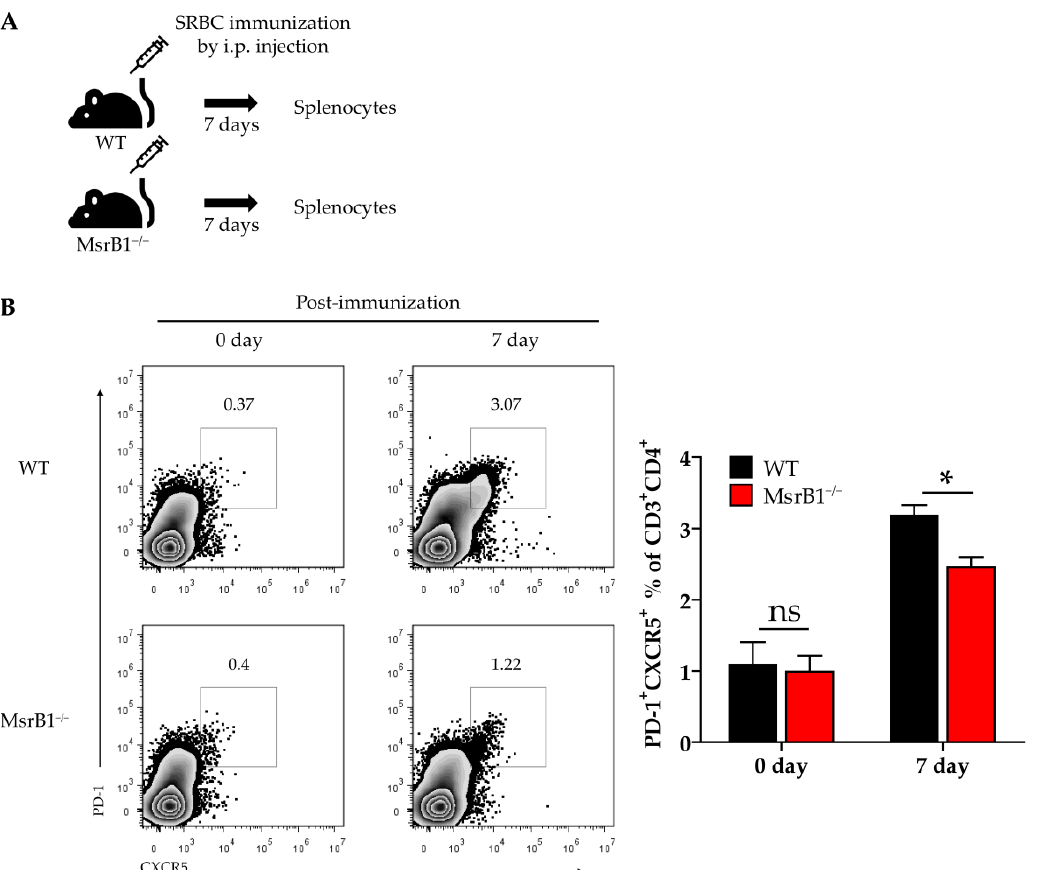
Figure 7. MsrB1 may promote follicular helper T-cell (Tfh) differentiation in vivo. ( A ) Schematic depiction of the sheep red blood cell (SRBC) immunization protocol. WT and MsrB1 −/− mice ( n = 6 per group) were injected intraperitoneally with SRBC and the splenocytes were isolated 7 days later. ( B ) The Tfh (PD-1 high CXCR5 high CD4 + ) cells in the spleen of the WT and MsrB1 −/− mice were measured by flow cytometry by gating on the CD3 + CD4 + cells in the live cells. Mean ± SEM are shown. * p < 0.05; ns, not significant, as determined by the Mann-Whitney U test. The data are representative of two experiments, which had similar results.